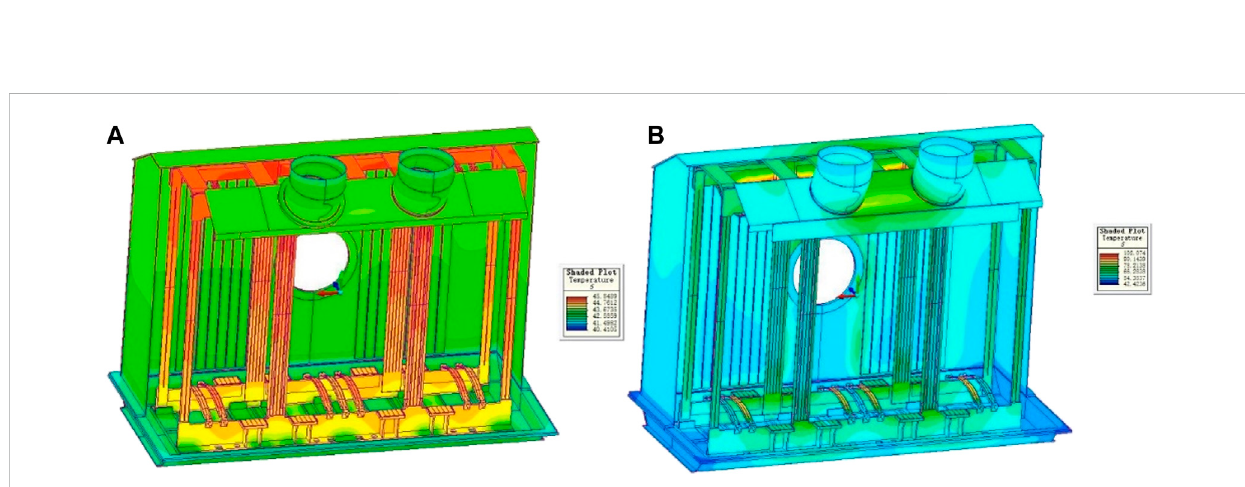
FIGURE 6 Cloud Map of Temperature Field Distribution in Oil Tank with Coupled Thermal Field at 40 ° C (A) 5% capacity (B) 85%